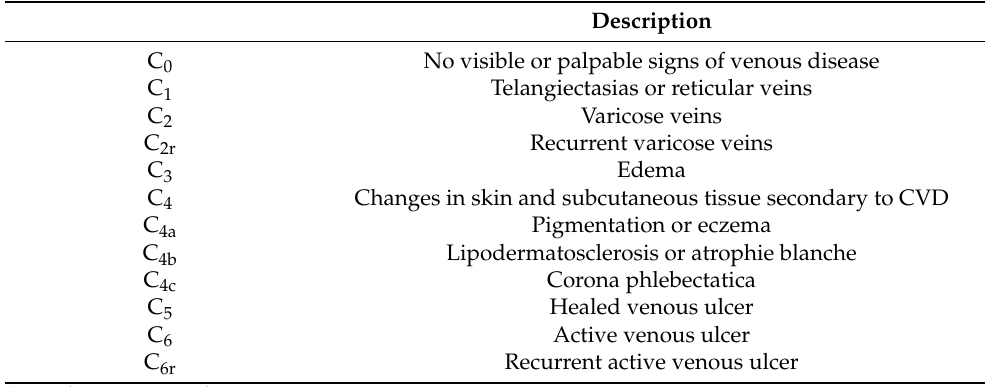
Table 1. The 2020 revision of CEAP: a summary of clinical classifications for cardiovascular dis- ease [40]. Reprinted from [40], with permission from